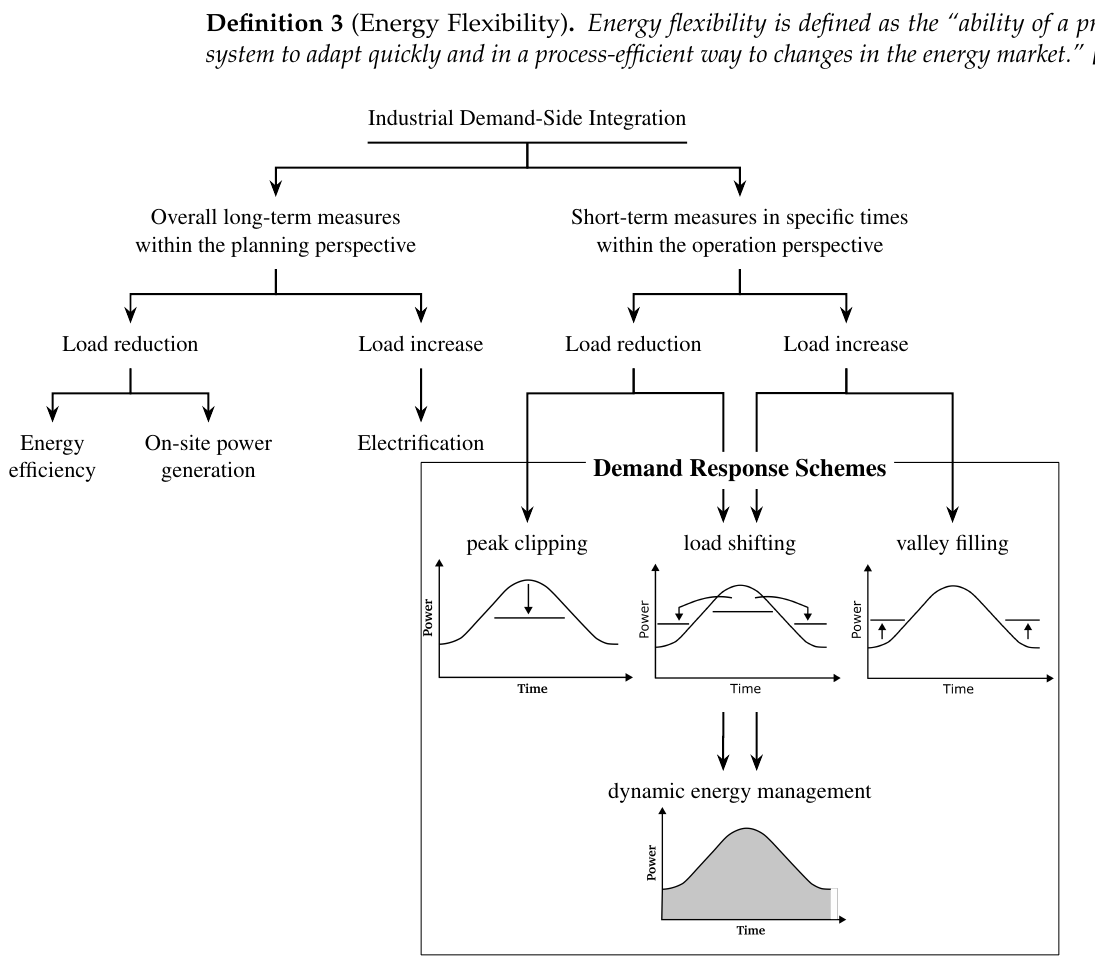
Table 1. Similarities and differences between the different concepts